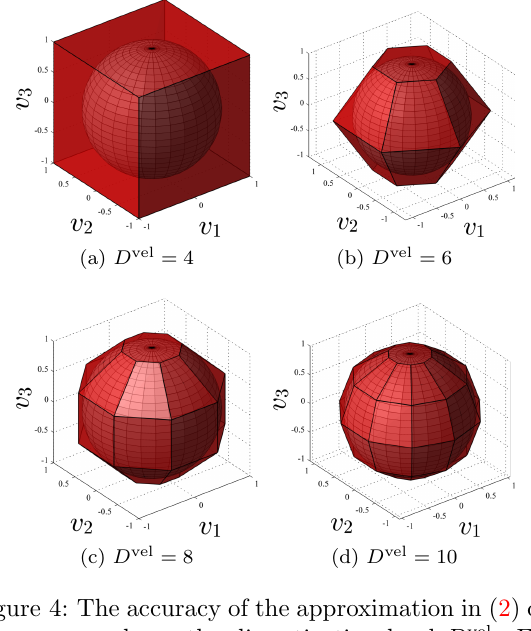
Figure 4: The accuracy of the approximation in (2) de- pends on the discretization level D vel . Fig- ures 4a ( D vel = 4), 4b ( D vel = 6), 4c ( D vel = 8), 4d ( D vel = 10) show that by including all constraints ∀ l ∈ { 1 , . . . , D vel / 2 } the velocity vector is restricted to be within a polytope approximating the unit sphere in 3D